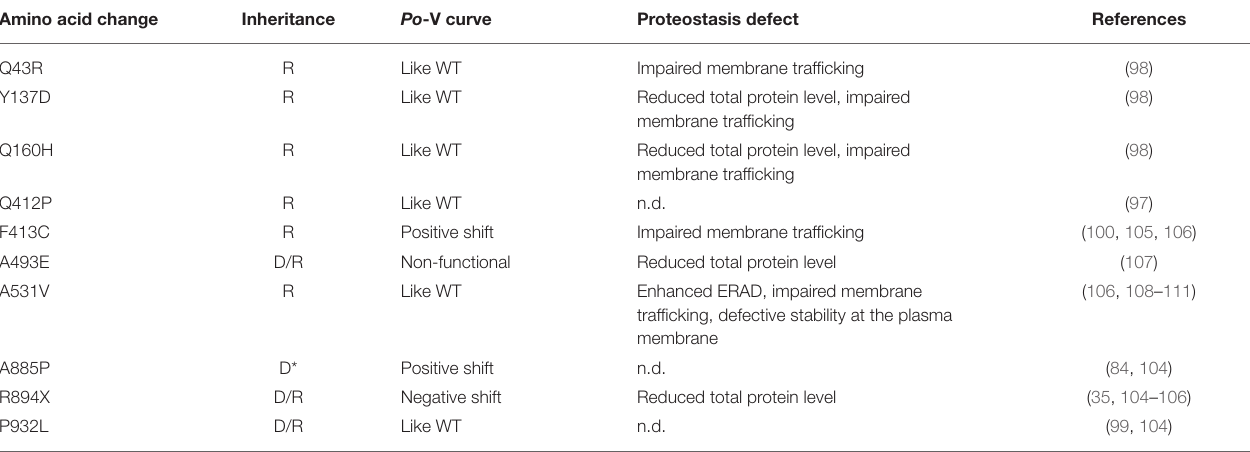
TABLE 1 | Gating and proteostasis properties of myotonia-causing mutant ClC-1 channels associated with reduced surface protein expression. Amino acid